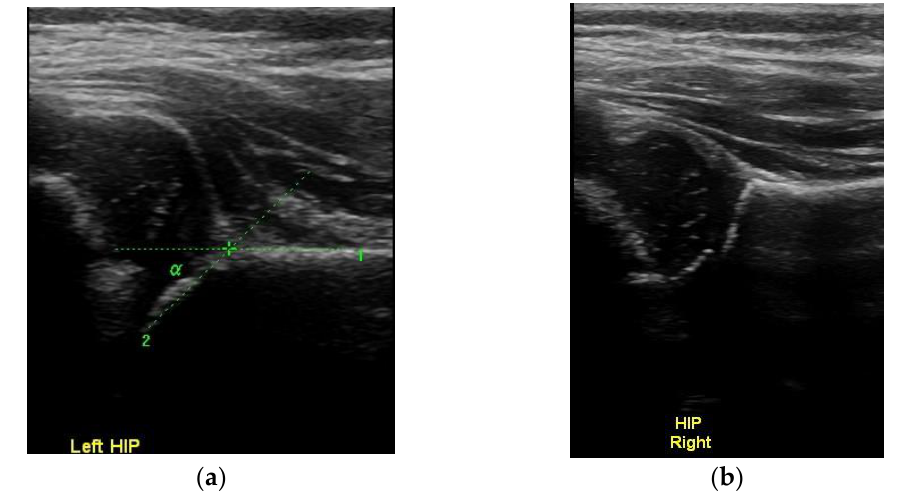
Figure5. Image showing DDH ( a ) on the left hip, with the spherical head lying on the upper part of the elliptic shape acetabulum and ( b ) the normal right hip.